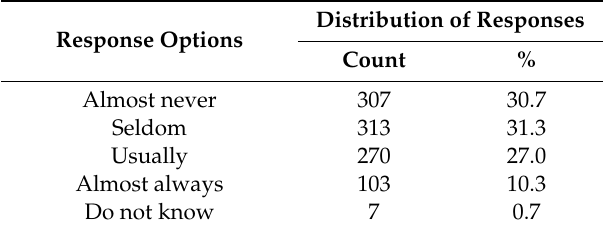
Table 3. The distribution of responses to the question: “How often do you avoid “stocking up” on tempting foods?” ( n = 1000).